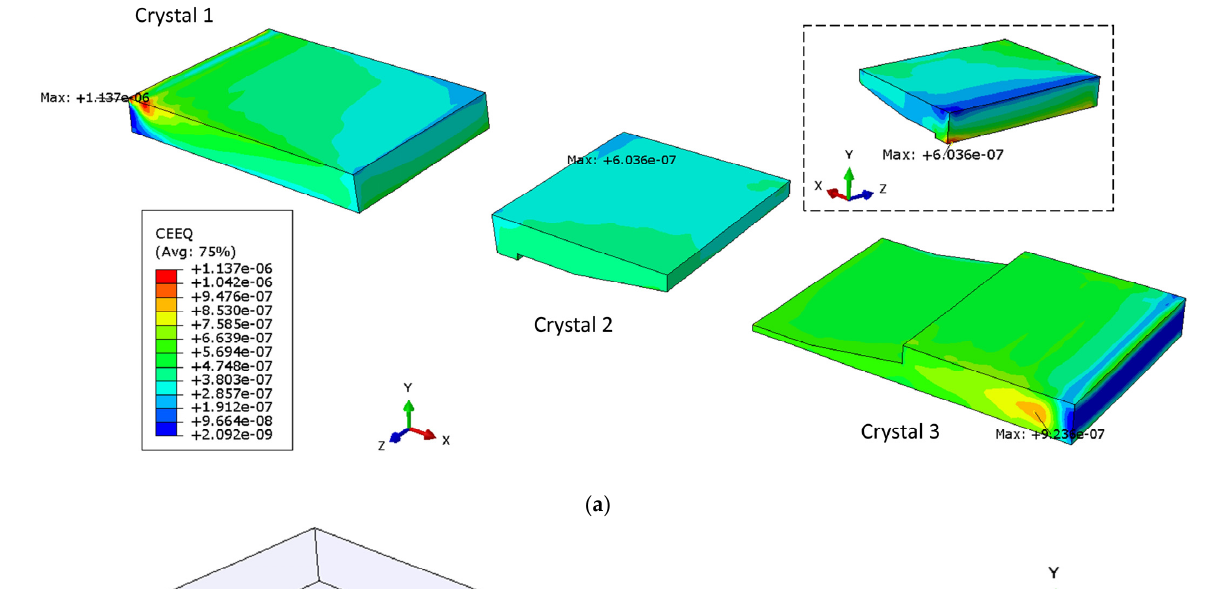
Figure 9. Equivalent creep strain contour of Sample 1 in: ( a ) each crystal, ( b ) grain boundary region. Figure 10 displays the corresponding contours of the equivalent creep strain for Sam- ple 2. The maximum strain ratio between the grain boundary and crystals is more than 70. joint. The maximum value for Crystal 2 is located at one vertex common to Crystals 1, 2